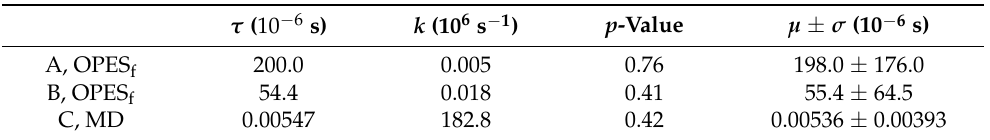
Table 2. Drug release time ( τ ) and rate ( k = 1/ τ ) for structures A, B and C of Figure 3. p -value measures the quality of the fit using the Kolmogorov–Smirnov analysis. We also present the average release time µ and its standard deviation σ